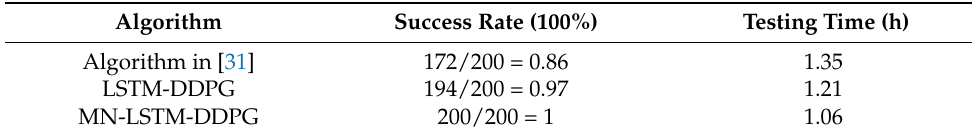
Figure 10. The movement process of mobile robot in simulation Figure 6c. Table 2. Comparison of test results of the improved algorithm in simulation Figure 6a. Algorithm